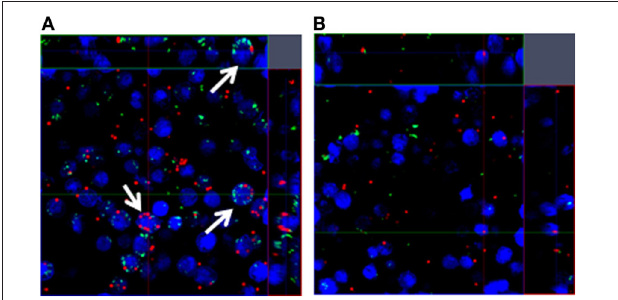
FIGURE 3 | Macrophage activation pathways. Depending on the local cytokine milieu, macrophages can be polarized toward a classical M1 or alternatively activated M2 phenotype, which possess potent antimicrobial and pro-fibrotic activities, respectively. Based on these attributes, and the finding that S. aureus biofilms are associated with a prominent M2 macrophage infiltrate, we propose that the ability of biofilms to elicit a M2 dominant response is responsible, in part, for biofilm persistence in an immunocompetent host.